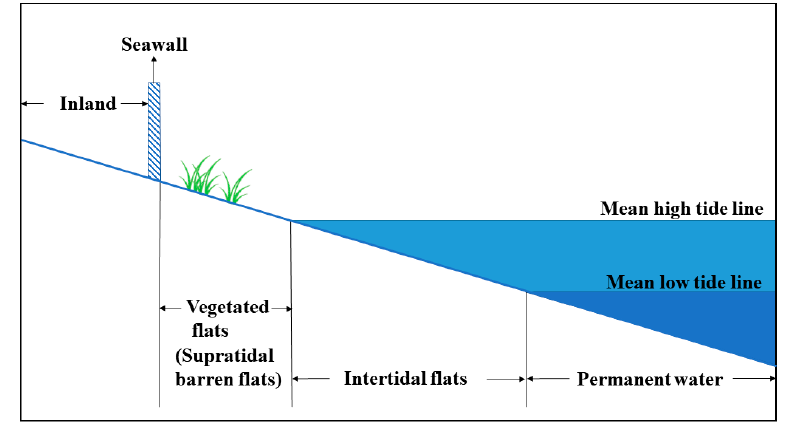
Figure 1. Sketch-map of tidal flat classification used in this study: intertidal flats, supratidal barren flats and vegetated flats.